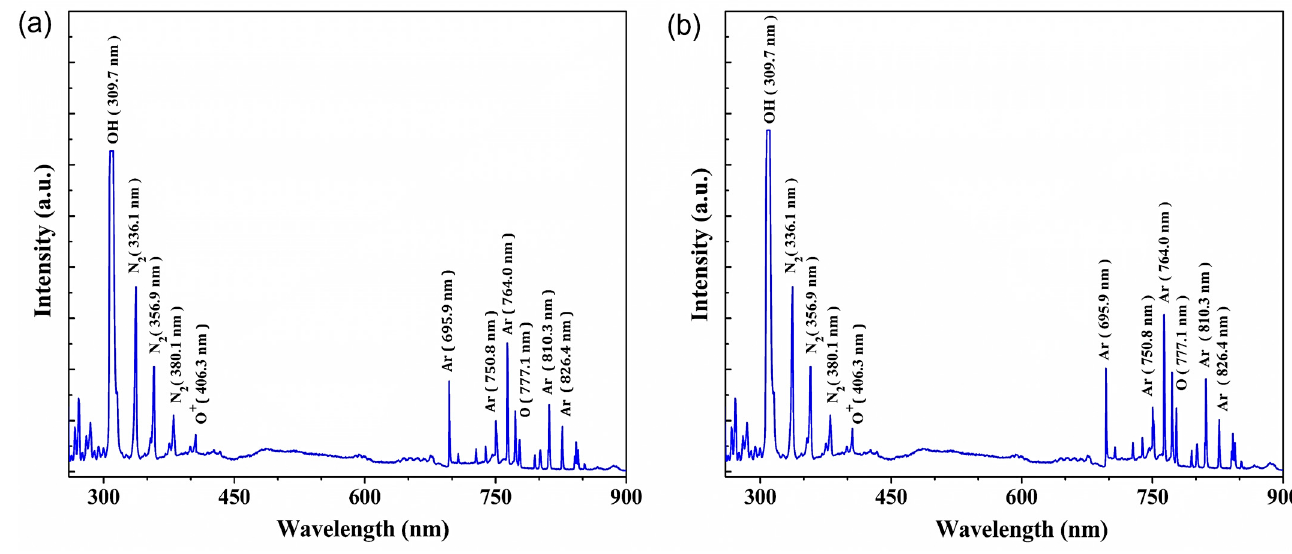
Figure 3. Representative OES of ( a ) argon gas and ( b ) Ar + O 2 gas plasma.